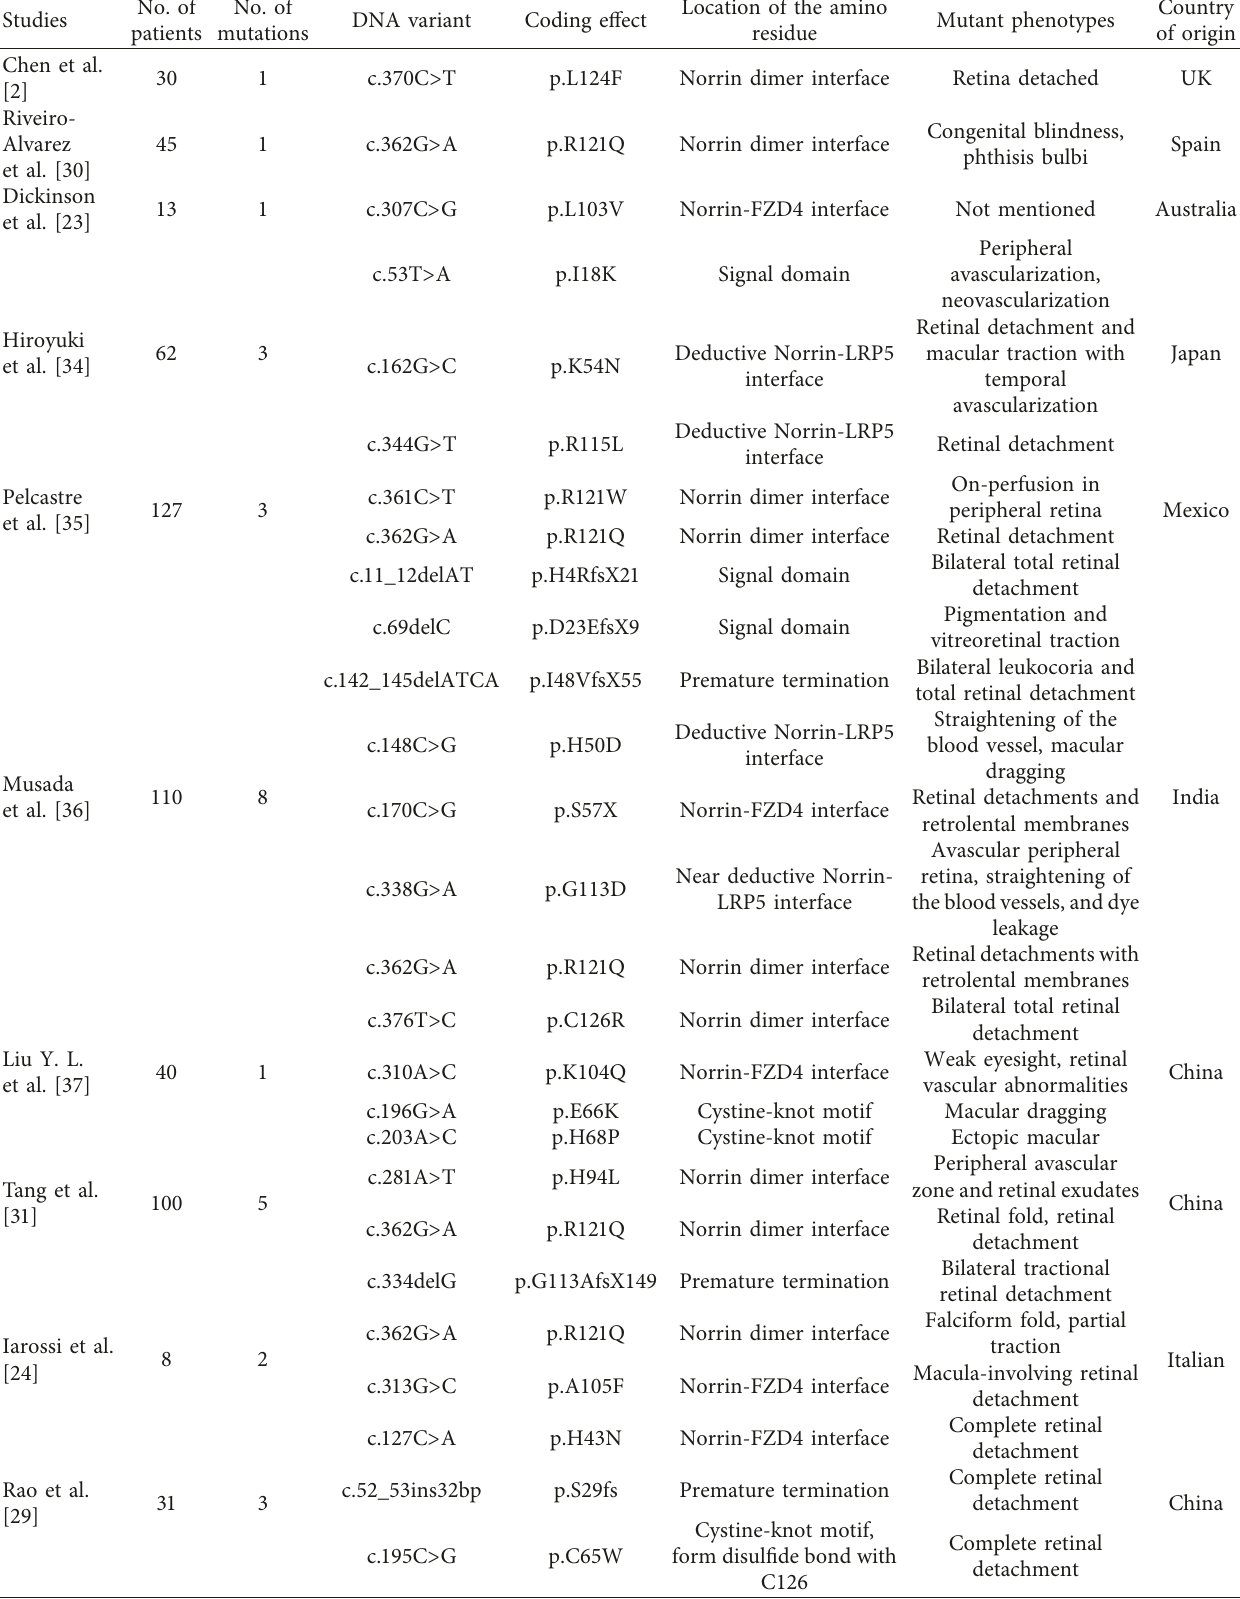
Table 1: Spectrum of NDP gene mutations among patients with familial exudative vitreoretinopathy.